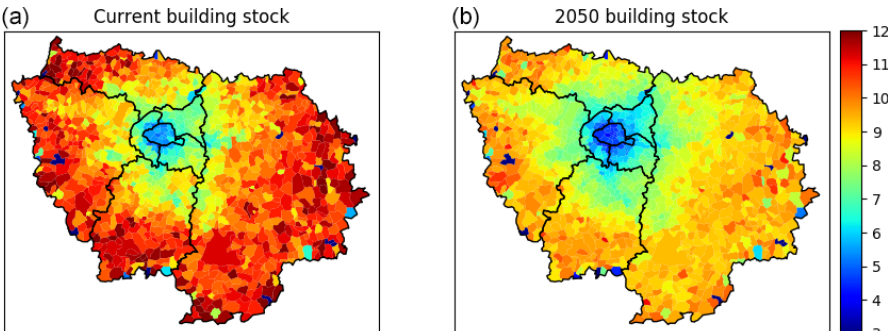
Figure 13. Exposure to O 3 (µgm − 3 ) considering the actual building stock (a) and the 2050 horizon projection of the building stock (b)